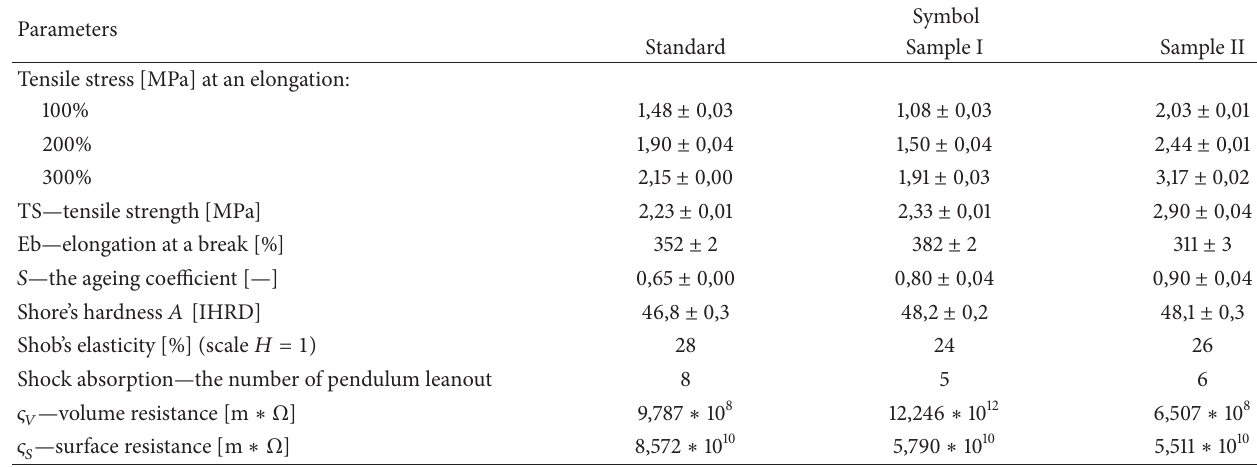
Table 4: The influence of keratin on the mechanical properties of NBR